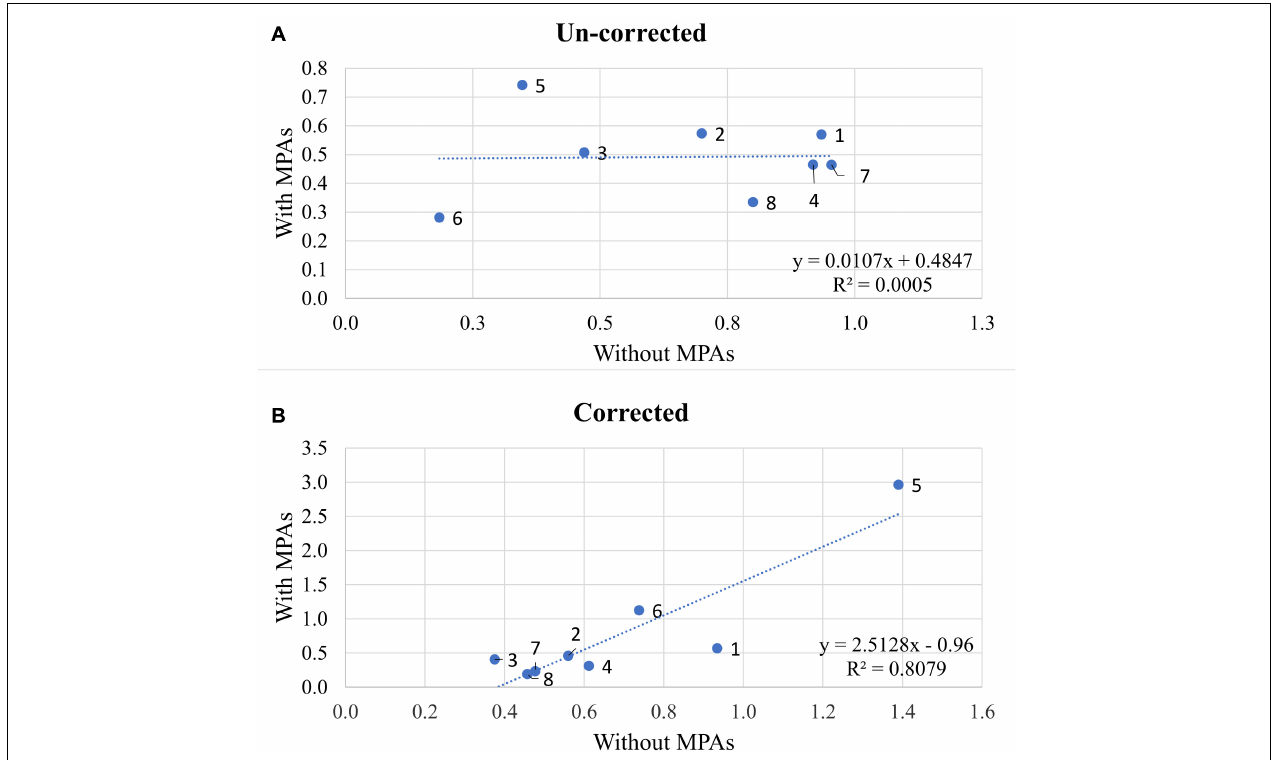
FIGURE 5 | Cost/effectiveness ratio for each of the eight scenarios studied, with and without current Marine Protected Areas (MPAs), without correcting (A) and correcting (B) with the weighting factors proposed in Table 1